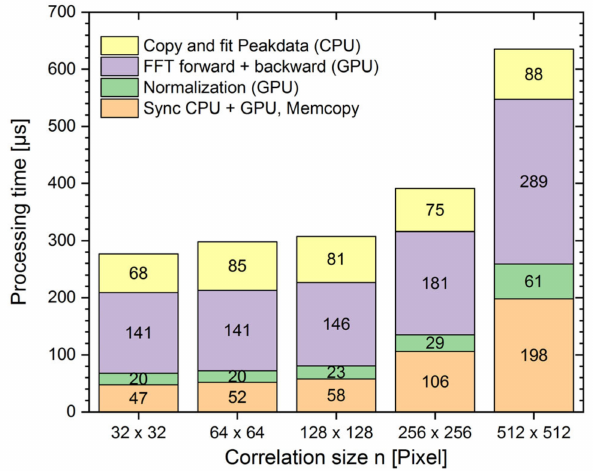
Figure 4. Performance test results processing two subsets per image. The height of the bars gives the total processing time for two subsets per image, the numbers within each field give the processing time for each step in